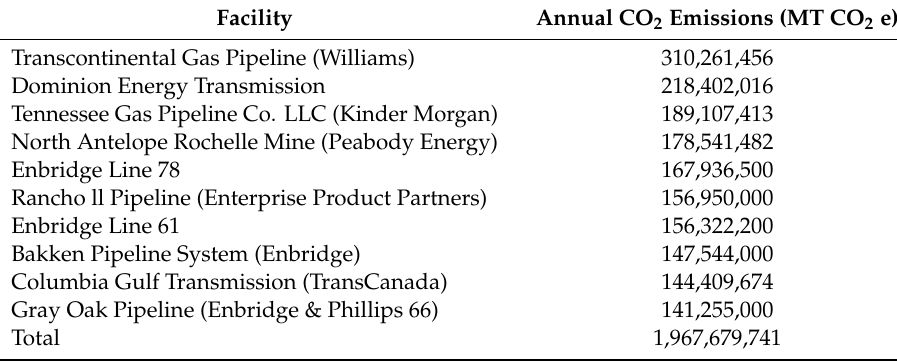
Table A8. Overall Top 10 CO 2 Emission Bottlenecks Across All Fossil-Fuel